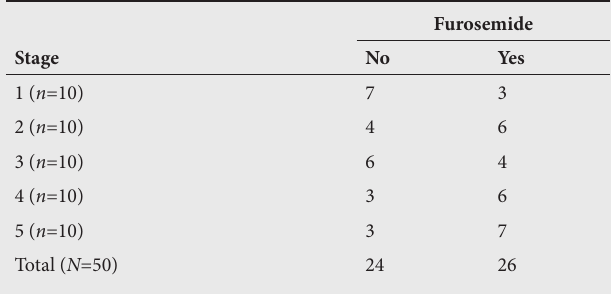
Table 9. Cross tabulation of furosemide intake across the five stages of chronic kidney disease Stage